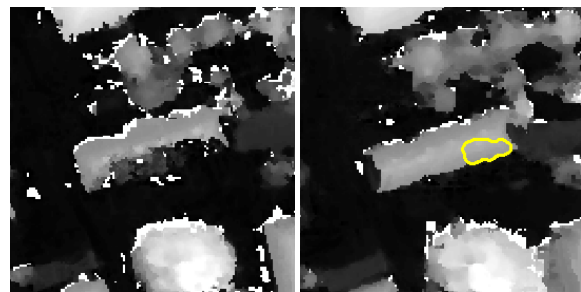
Figure 12. Left: normalized DSM (2010) Right: normalized DSM (2012) with a false indication of a new building